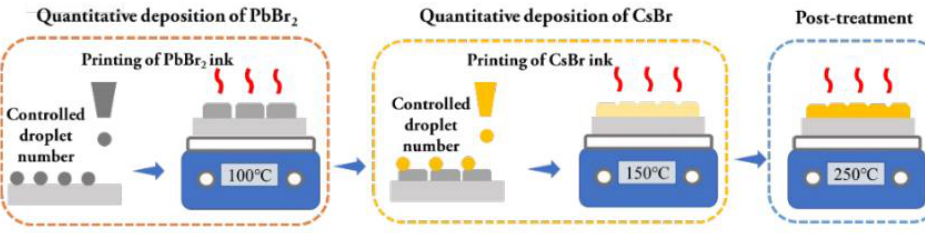
Figure 9. Diagram of the inkjet-printing process of CsPbBr 3 films [56].